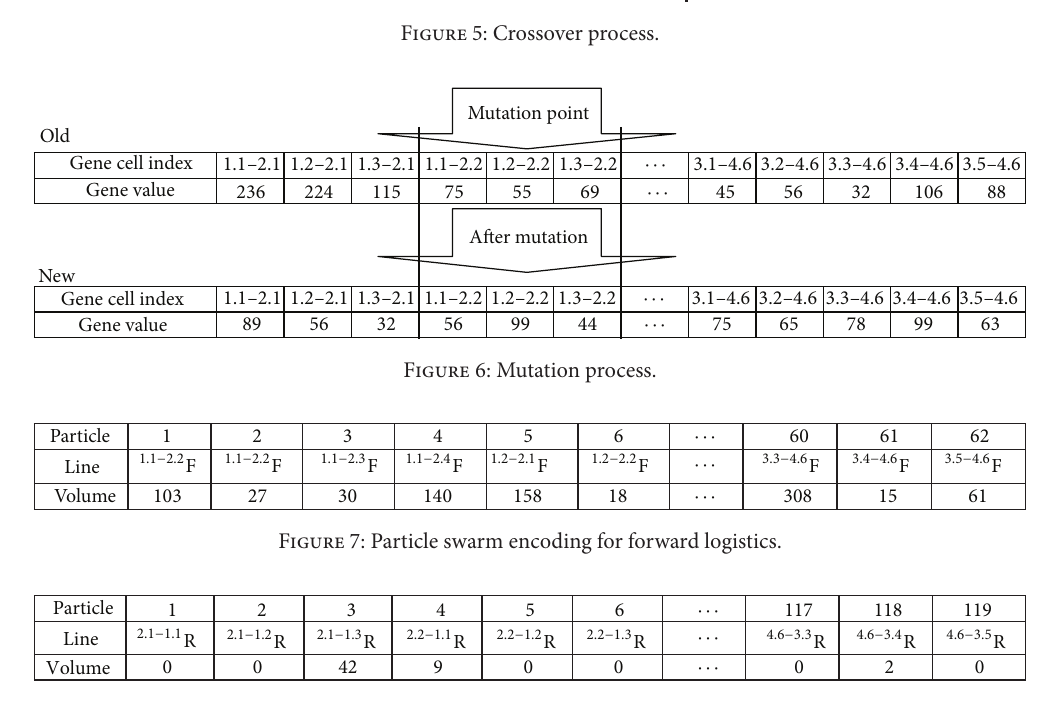
Figure 8: Particle swarm encoding for reverse